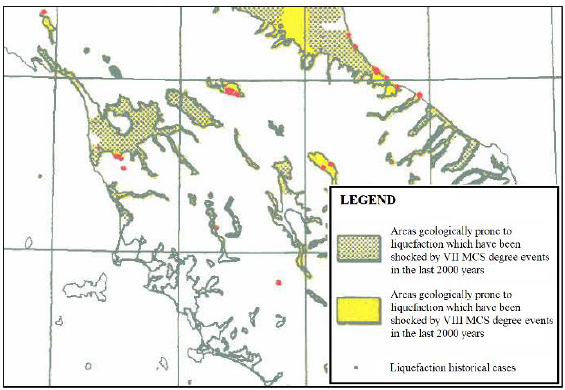
Figure 2. Areas geologically prone to liquefaction in the study area (adapted from Galli and Meloni [47]).